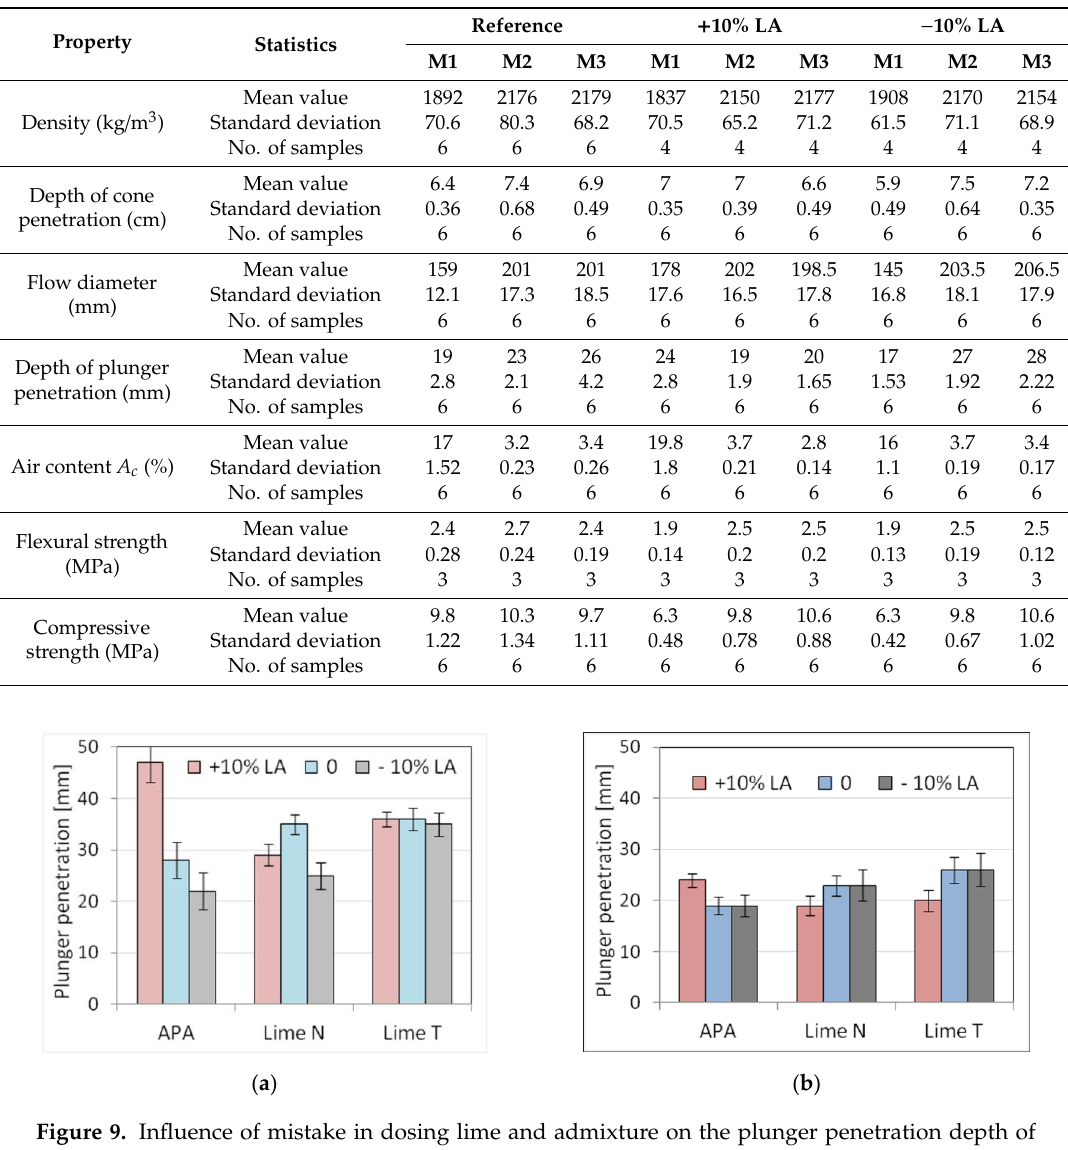
Figure 9. Influence of mistake in dosing lime and admixture on the plunger penetration depth of ( a )